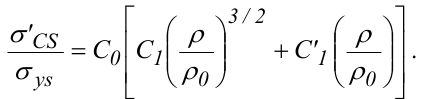
Figure 2: Scaling of the compression strength for AlSi11Mg0.6 foam without surface skin  20 x {10, 20, 30, 40} mm 2 .